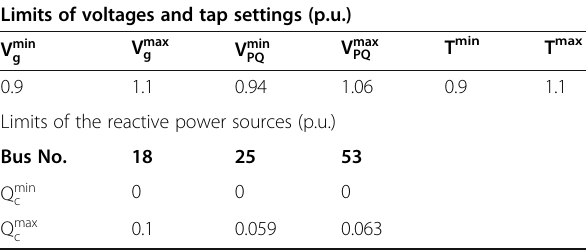
Table 7 Control variable limits (p.u.) for the test cases Limits of voltages and tap settings